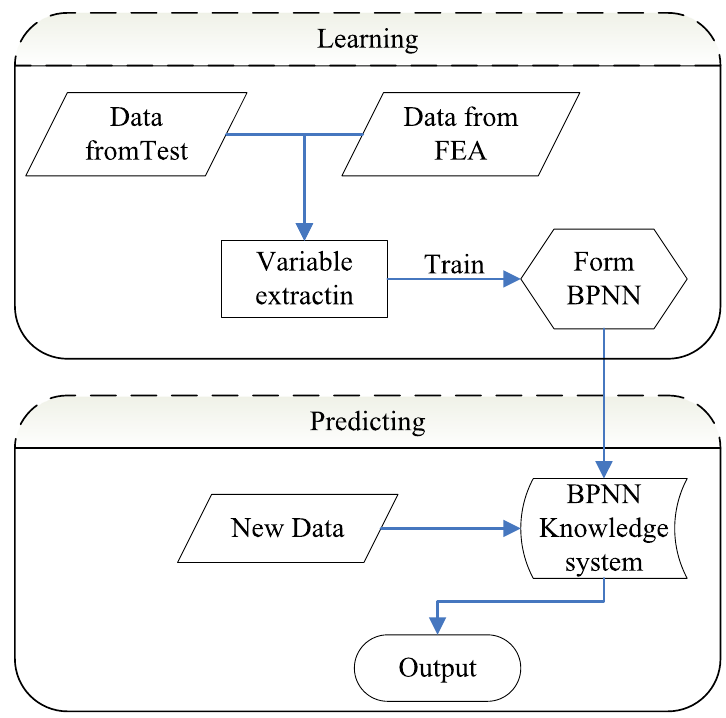
Fig. 9 learning and predicting process of